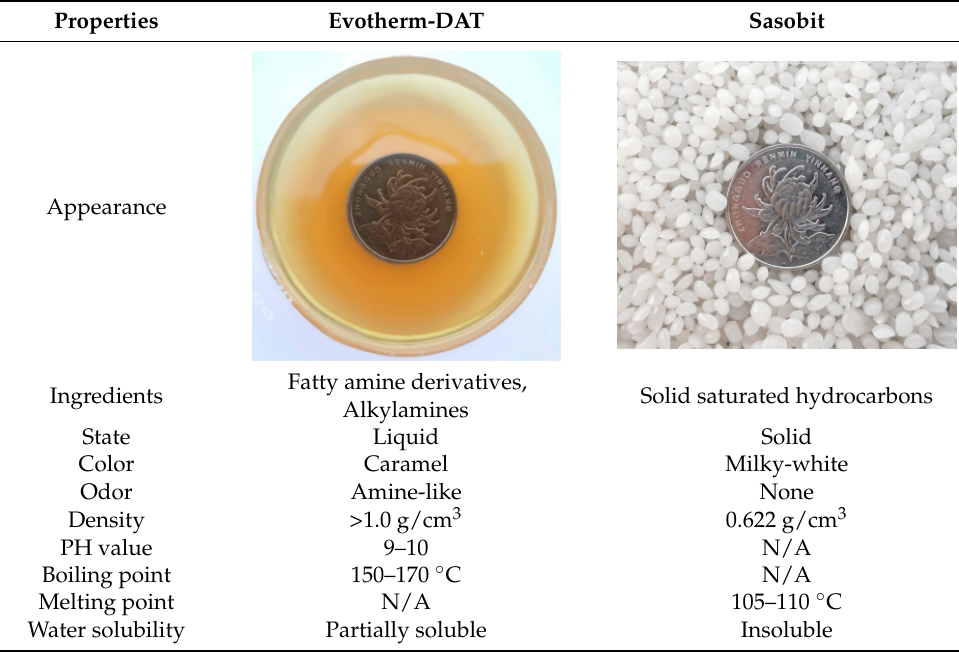
Table 2. Properties of Evotherm-DAT and Sasobit.